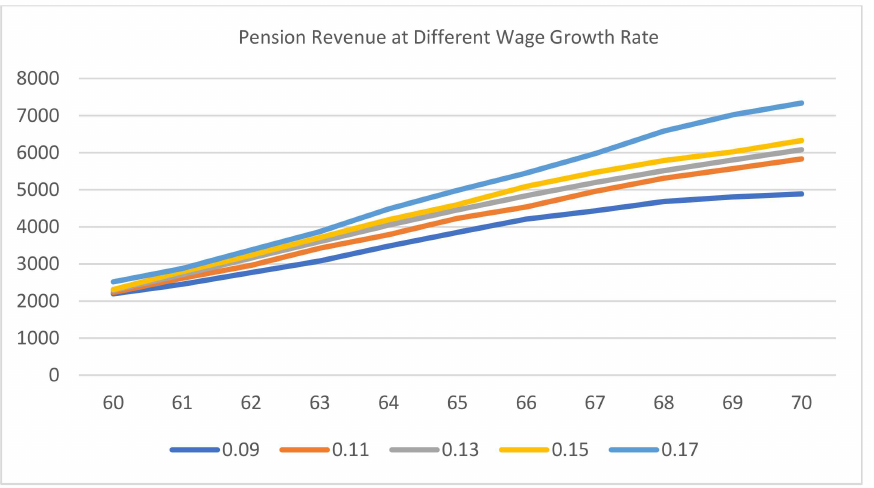
Figure 5. Pension revenue at different wage growth rates under plan